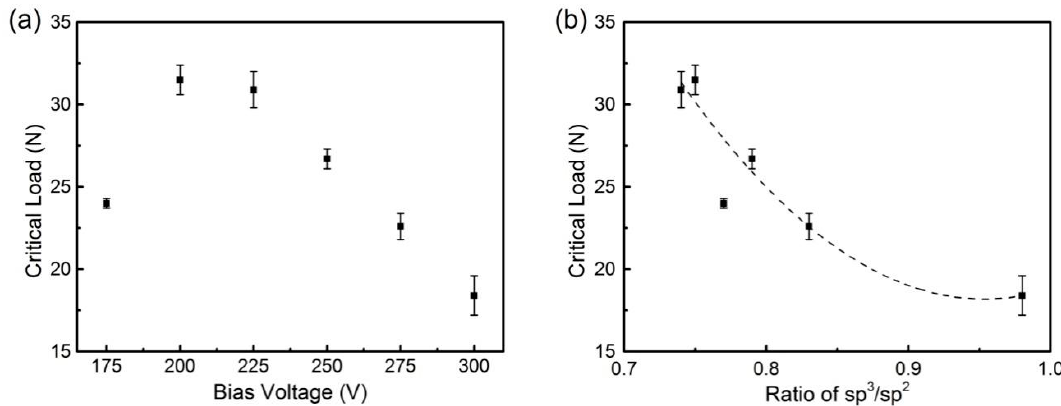
Figure 5. ( a ) Critical loads of DLC films under different bias voltages. ( b ) Critical loads as a function of the ratio of sp 3 /sp 2.